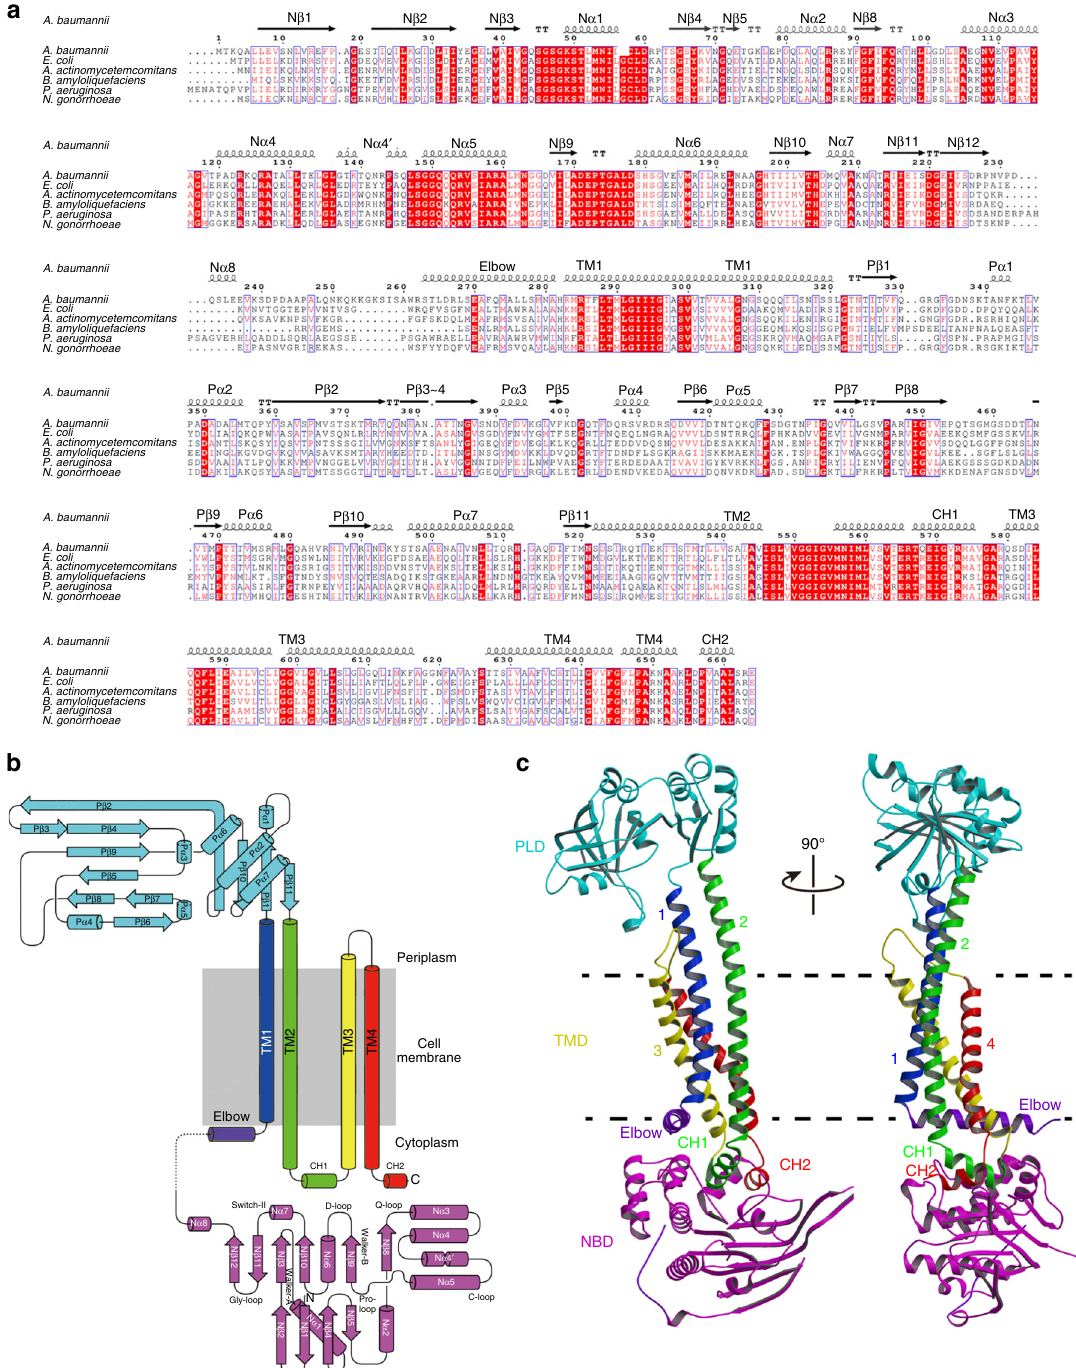
Fig. 3 Sequence conservation among MacB proteins, secondary and tertiary structures of Acietobactor MacB. a Amino acid sequence alignment of MacB from A. baumannii with fi ve MacB orthologues from Actinobacillus actinomycetemcomitans ( Aggregatibacter actinomycetemcomitans ), Bacillus amyloliquefaciens , E. coli , P. aeruginosa and N. gonorrhoeae . Alignment was generated with the ClustalW multiple sequence alignment tool 57 . Strictly conserved and highly conserved residues are highlighted in red boxes and red lettering, respectively. Major secondary structure elements are shown on top as coils and arrows for α -helices and β -strands, respectively. Labelling of the secondary structure elements in NBD are according to convention 58 . Alignment was displayed using ESPript 3.0 (http://espript.ibcp.fr/ ESPript/ESPript/) 59 . b Topology diagram of MacB monomer. Secondary structure elements are indicated with the same annotation as in ( a ). Dotted line shows a disordered polypeptide segment at position 248 – 259. Designated motifs in NBD are indicated. N and C refer to amino- and carboxy-terminus, respectively. Walker- A, Walker-B, C-loop, D-loop, Q-loop, Gly-loop and Switch-loop are conserved sequence elements in ABC NBDs. c Monomer structure of MacB in two orientations, rotated by 90° around a vertical axis to the membrane plane. In b and c , following colouring is used: NBD in magenta; TMD containing TM1, TM2, TM3 and TM4 in blue, green, yellow and red, respectively; PLD in cyan; elbow in purple. Coupling helix 1 (CH1) between TM2 and TM3 in green. C-terminal CH2 in red. Dotted black lines depict the approximate membrane boundaries on the basis of the hydrophobicity of the protein surface and location of elbow helix. TMs, transmembrane helices; N α and N β , helices and strands in NBD; P α and P β , helices and strands in PLD; Elbow elbow helix, CH, coupling